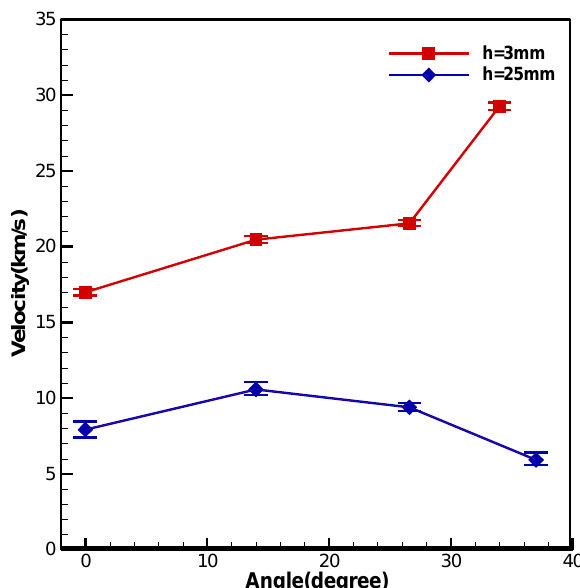
Figure 13. The variation of the average velocity of the ablative propellant with the flare angle of the tongue-shaped electrode.